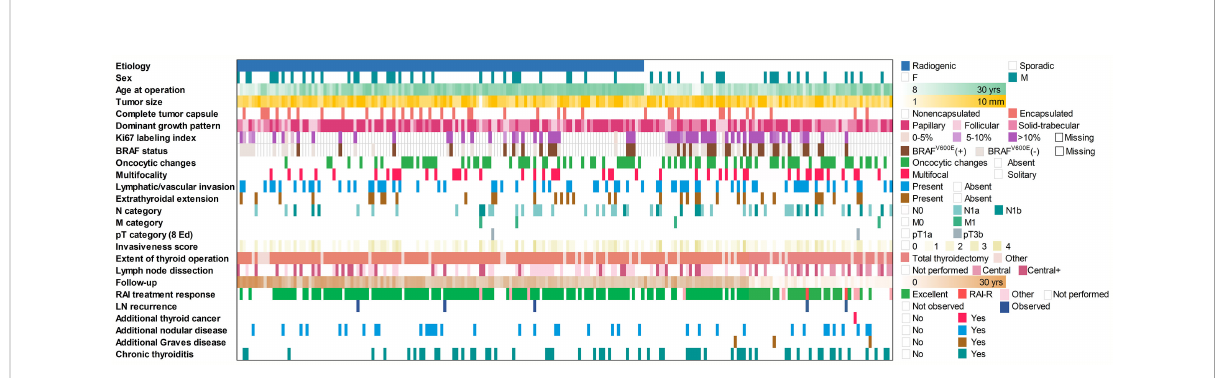
FIGURE 1 Baseline and clinicopathological pro fi le of 136 radiogenic and 83 sporadic papillary microcarcinomas in the